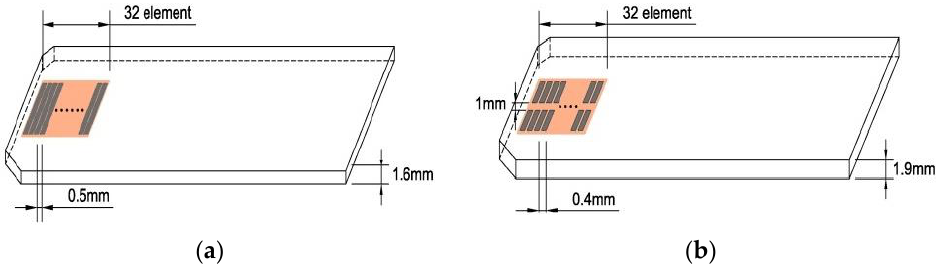
Figure 5. Images of phased array probe with a flexible structure geometry excluding solid wedge: ( a ) 32channel(ch), P/E, pitch 0.5 mm; ( b ) 32ch × 2, T/R, pitch 0.4 mm. Table 1. Specifications of the two types of FPAPr.